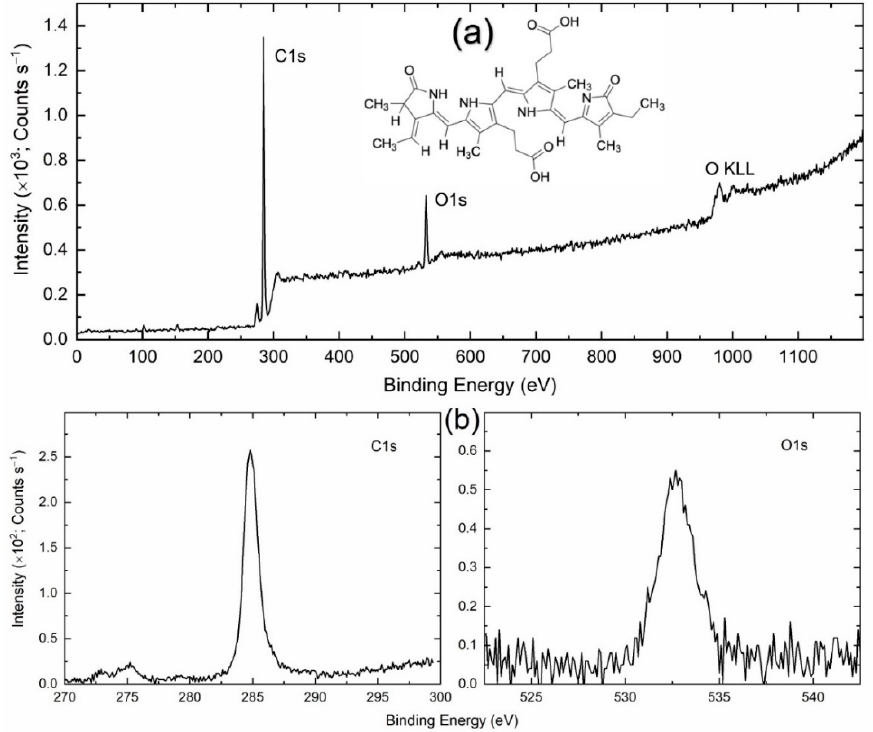
Figure 1. XPS spectra for ( a ) survey and ( b ) elements (C1s and O1s) of PCB-sensitized LDPE. The inset shows the chemical structure of PCB dye.